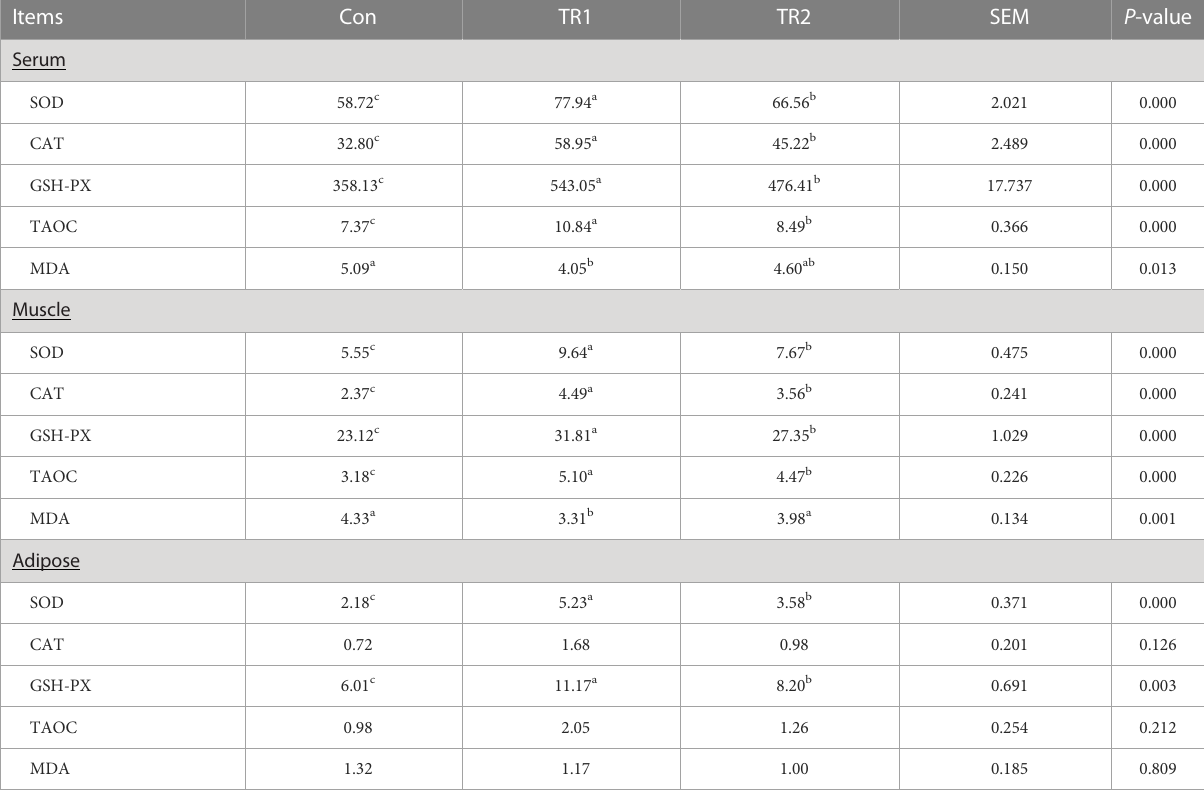
TABLE 4 Anti-oxidant properties of serum, muscle and adipose tissues.